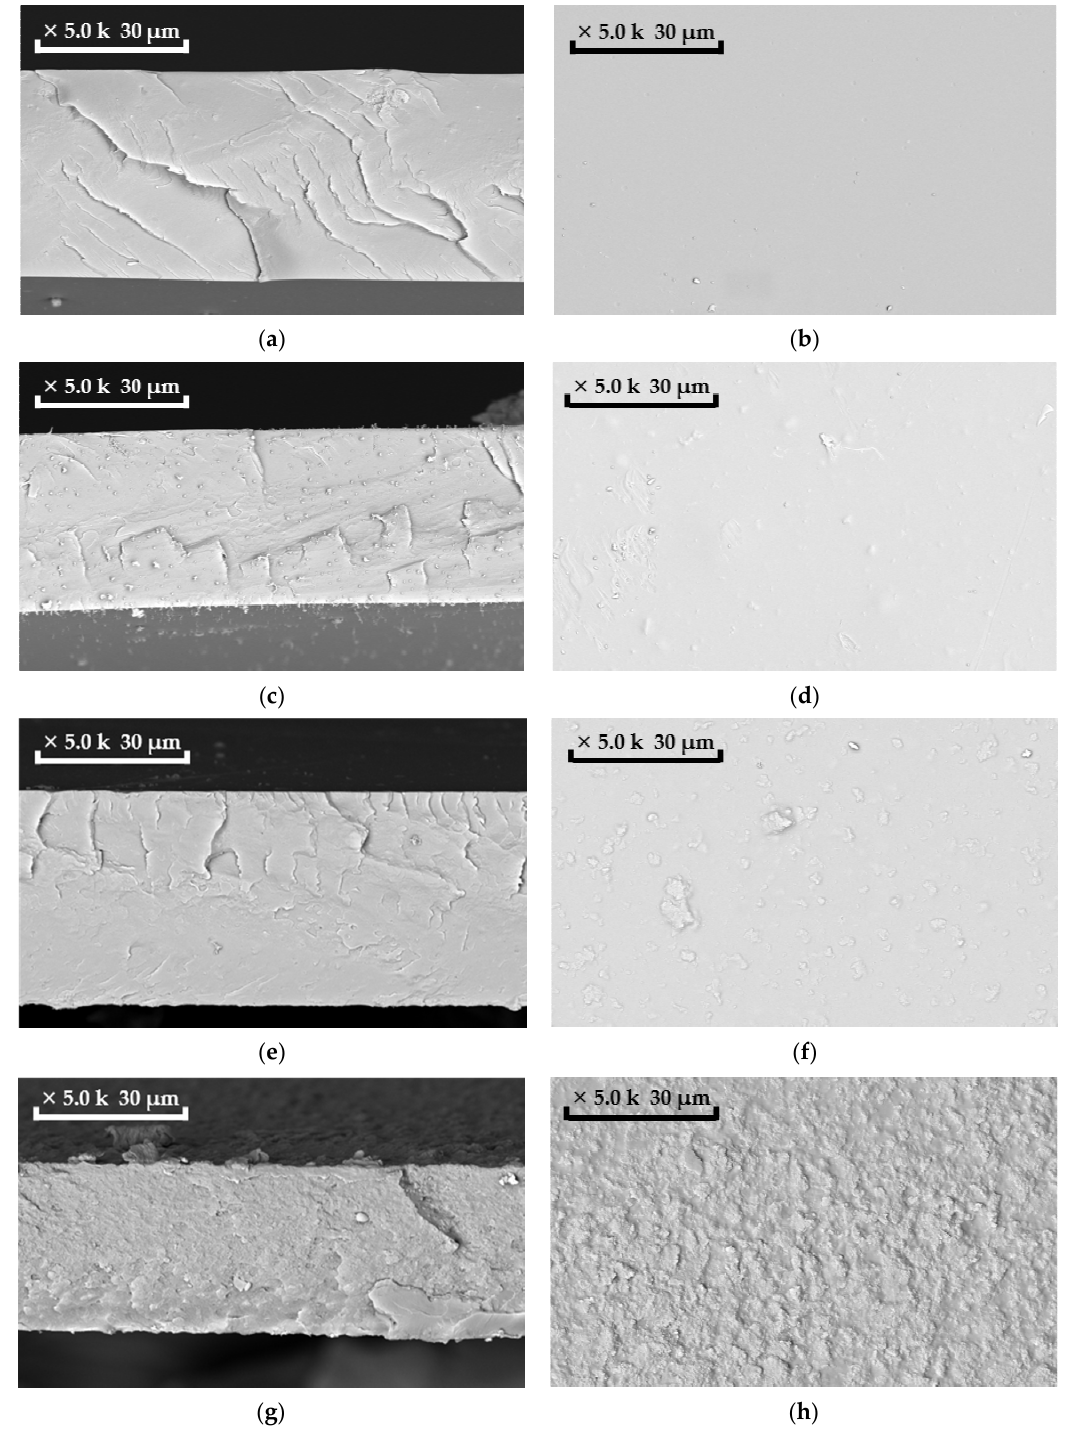
Figure 2. SEM images of membranes: ( a ) cross-section of PTMSP membrane, magnification 5000×; ( b ) top view of PTMSP membrane, magnification 5000×; ( c ) cross-section of membrane with 0.5 wt % HCPS content in PTMSP, magnification 5000×; ( d ) top view of the membrane with 0.5 wt % HCPS content in PTMSP, magnification 5000×; ( e ) cross-section of the membrane with 2.0 wt % HCPS content in PTMSP, magnification 5000×; ( f ) top view of the membrane with 2.0 wt % HCPS content in PTMSP, magnification 5000×; ( g ) cross-section of the membrane with 10 wt % HCPS content in PTMSP, magnification 5000×; ( h ) top view of the membrane with 10 wt % HCPS content in PTMSP, magnification 5000×.